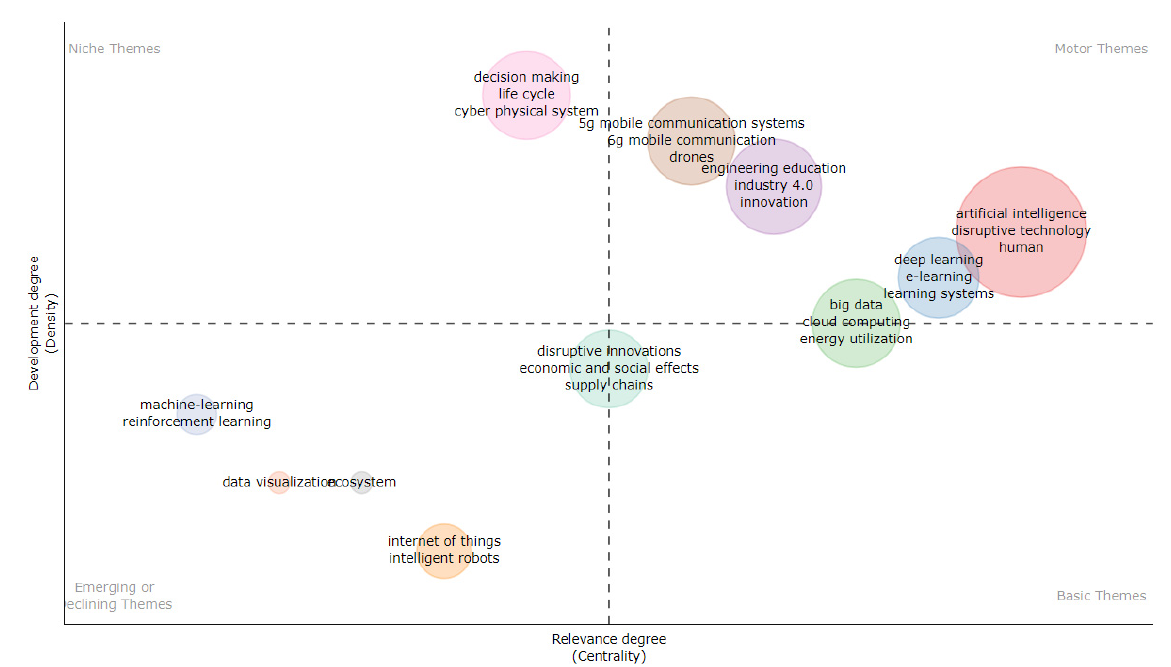
Figure 8. The 2021–2022 time slice of thematic evolution for analyzed articles (n = 97).